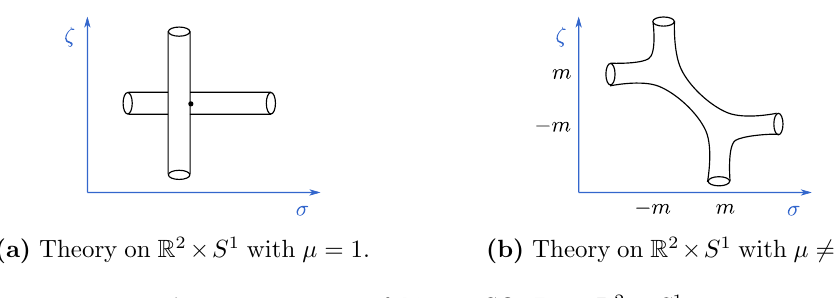
Figure 10. Vacua of N f = 1 SQED on R 2 (cid:2) S 1